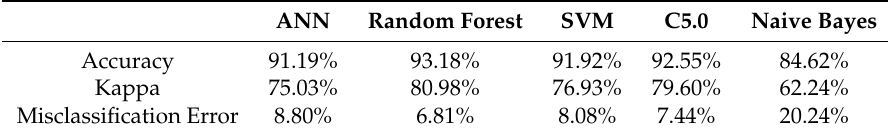
Table 3. Evaluation Criteria for CTG patient for prediction before Genetic Algorithm.